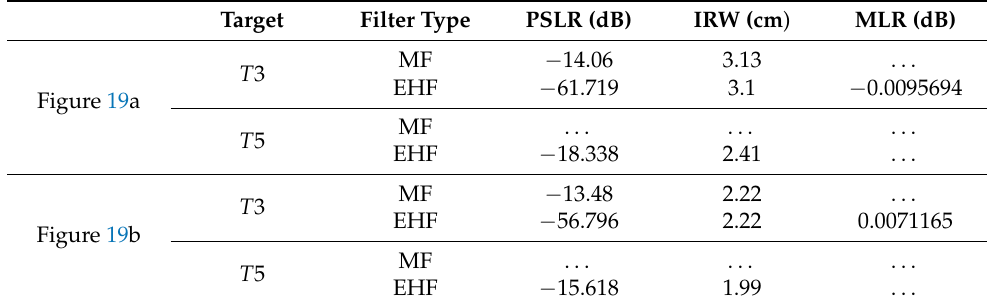
Table 5. Measurements of PSLR, IRW, and MLR, of T 3 and T 5, for MF and EMF, as shown in Figure